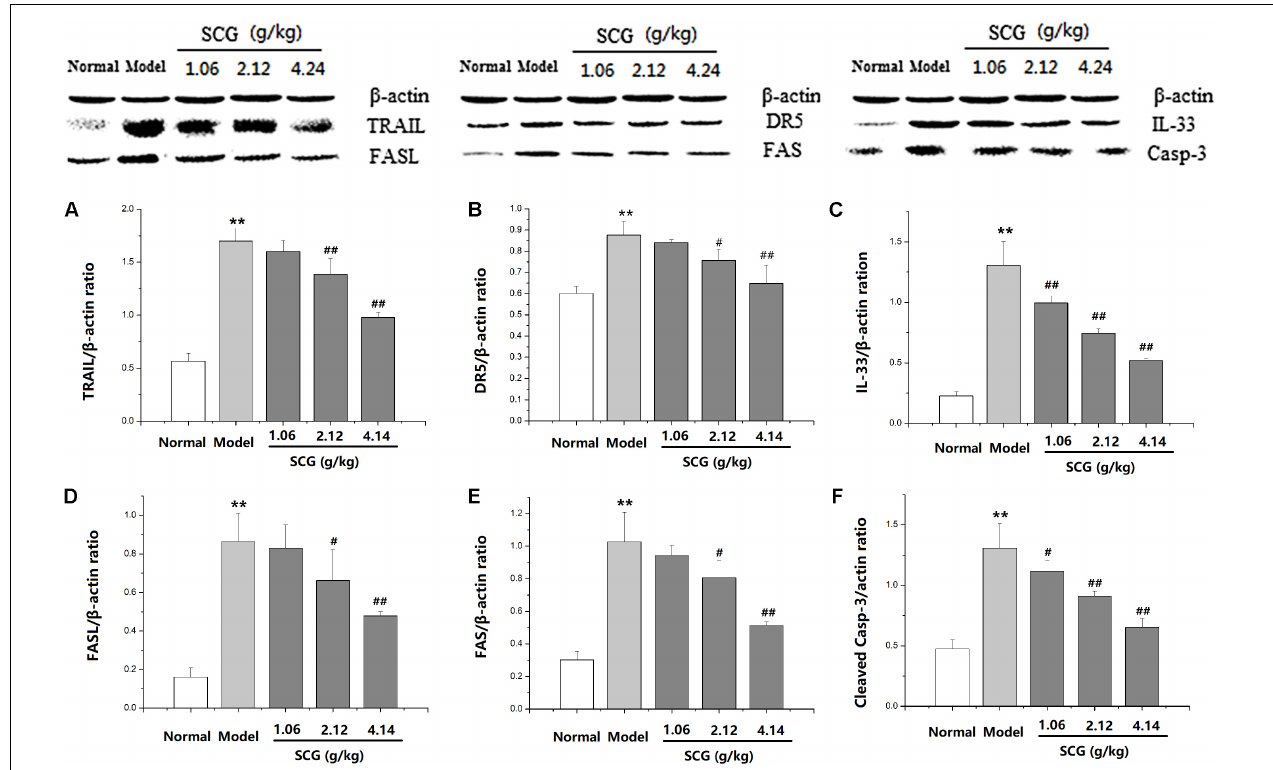
FIGURE 8 | Effect of SCG on protein expression of TRAIL, DR5, FASL, FAS, IL-33, and caspase-3 in Con A-treated mice. (A) The expression of TRAIL. (B) The expression of DR5. (C) The expression of IL-33. (D) The expression of FASL. (E) The expression of FAS. (F) The expression of cleaved caspase-3. Data were expressed as mean ± SD ( n = 3). ∗∗ P < 0.01 compared with normal group; # P < 0.05, ## P < 0.01 compared with model group.